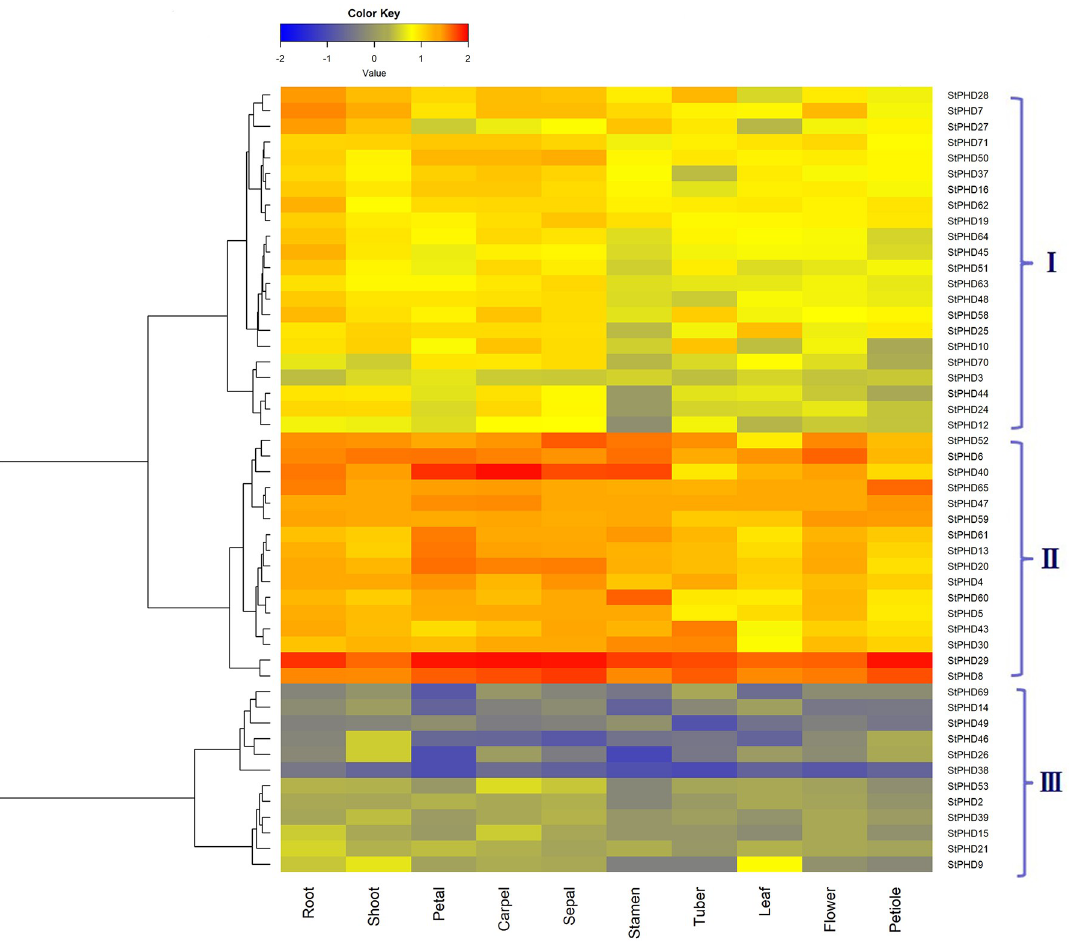
Fig 6. Expression heatmap of StPHD genes in different tissues. FPKM values for StPHD genes were transformed by log10.